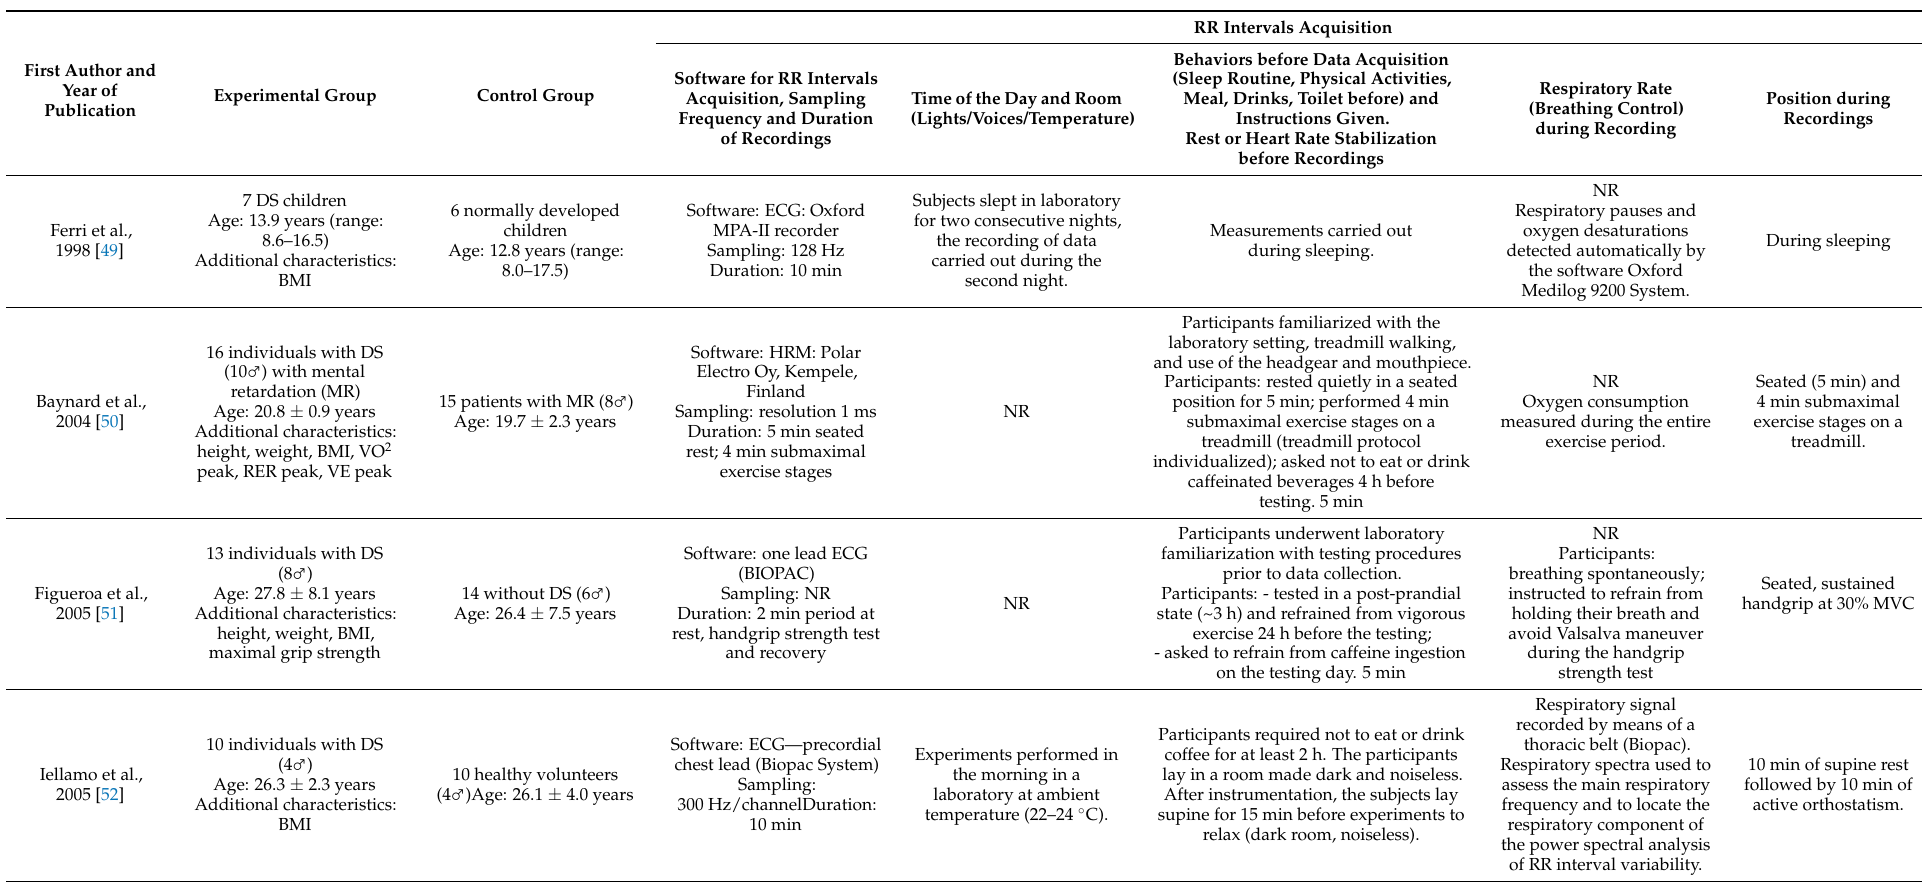
Table 1. Baseline characteristics of study participants and details concerning RR intervals